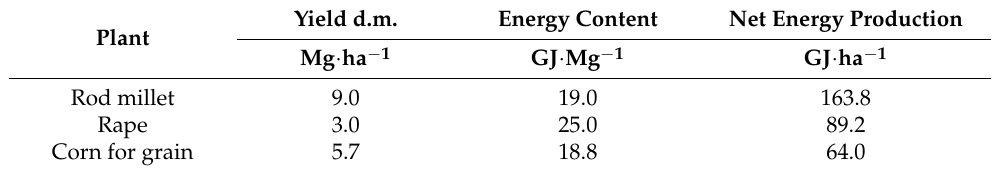
Table 17. Net energy production from millet